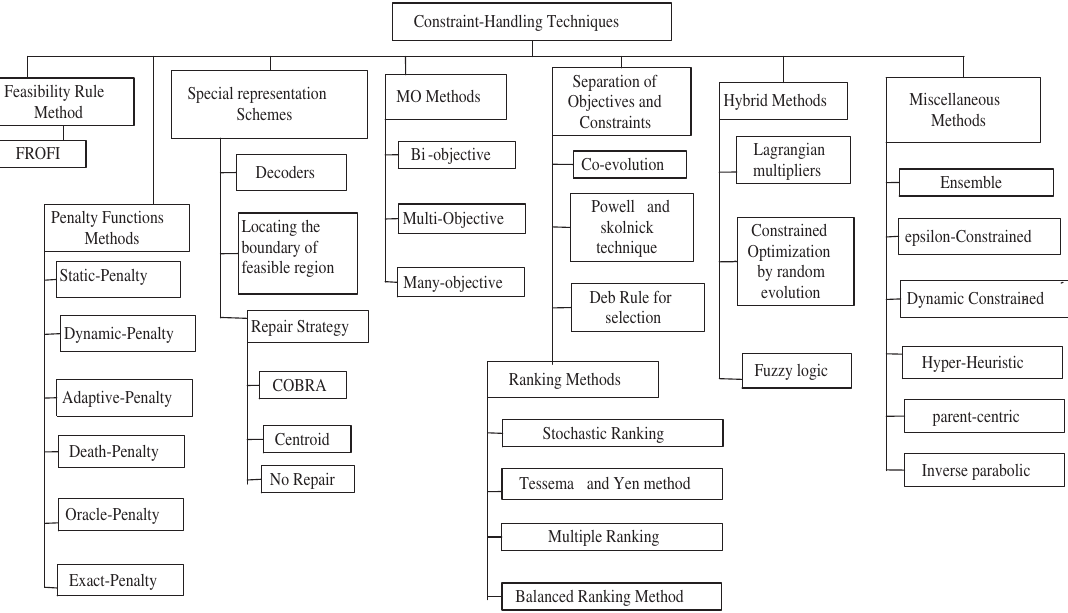
Figure 1. The classification of Constrained-Handling